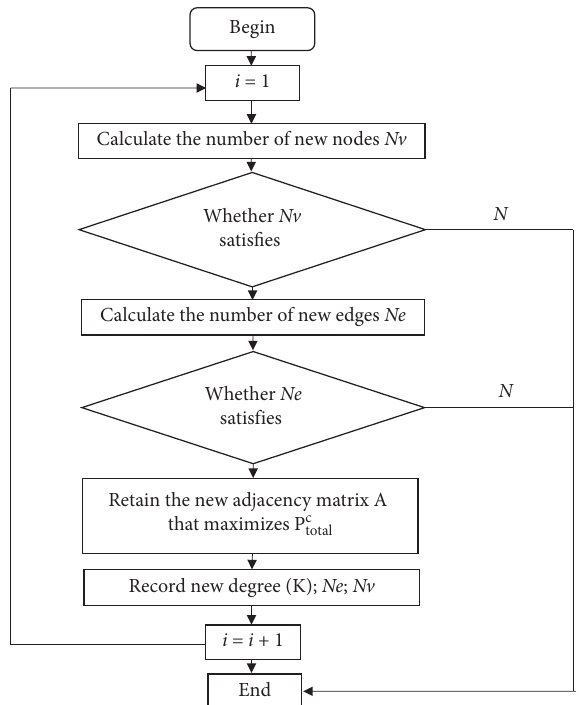
Figure 9: Flow chart of robust optimization.